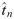
Multi-electrode recording from mouse mEC.Panel a shows an illustration of the silicone probe positioned along the dorsal-ventral axis of the mEC. Panel b is an example seizure-like onset from mEC data showing the slow domino effect, where sequential seizure-line onset starts in the ventral end and spreads to the dorsal. Panel c is the scaled mean recruitment times t^n and standard error for each electrode n = 1, …, 16 from six seizure-like events.